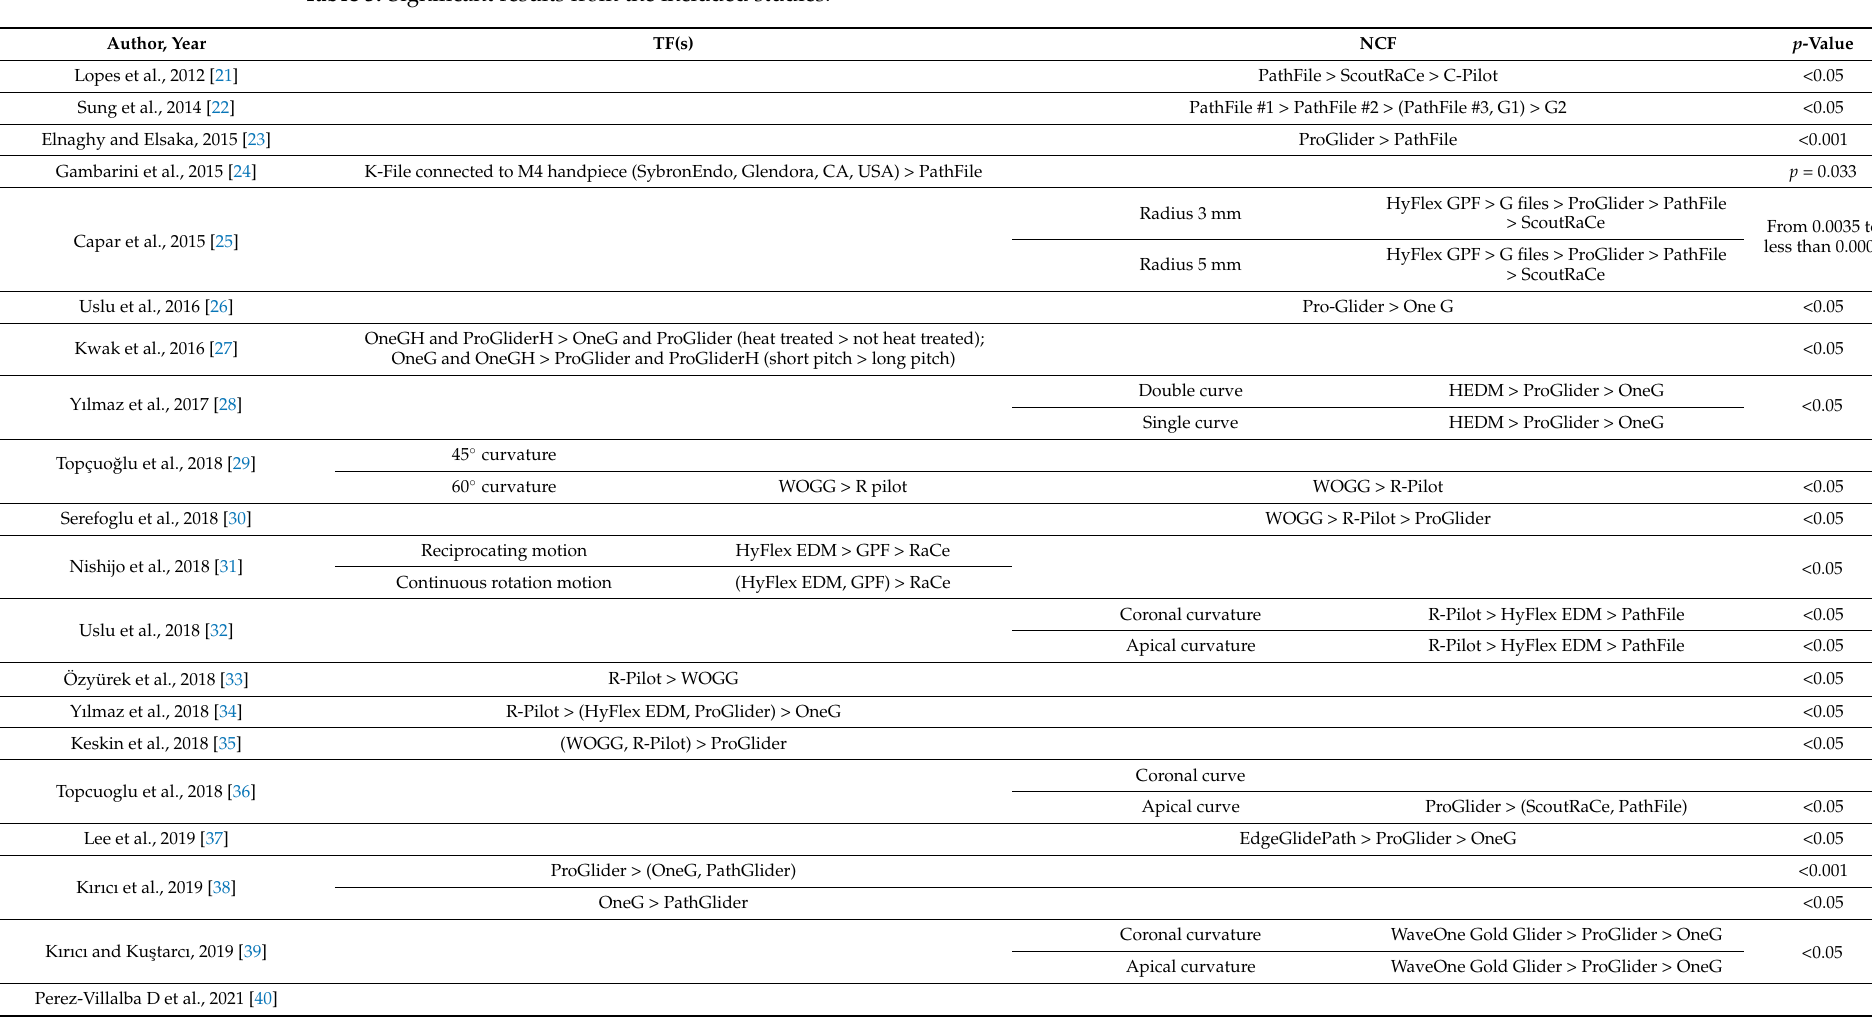
Table 3. Significant results from the included